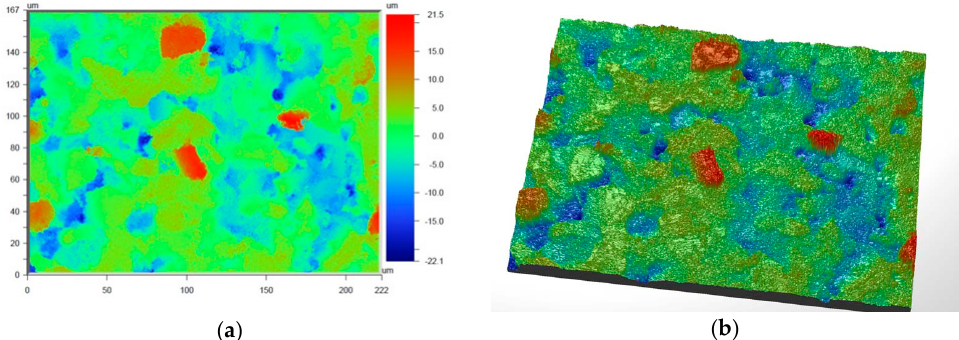
Crystals 2020 , 10 , x Figure 13. 2D ( a ) and 3D ( b ) profilographs of PW2 sample at a magnification of ×28.4. Figure 13. 2D ( a ) and 3D ( b ) profilographs of PW2 sample at a magnification of × 28.4. Figure 13. 2D ( a ) and 3D ( b ) profilographs of PW2 sample at a magnification of ×28.4. Figure 13. 2D ( a ) and 3D ( b ) profilographs of PW2 sample at a magnification of ×28.4.